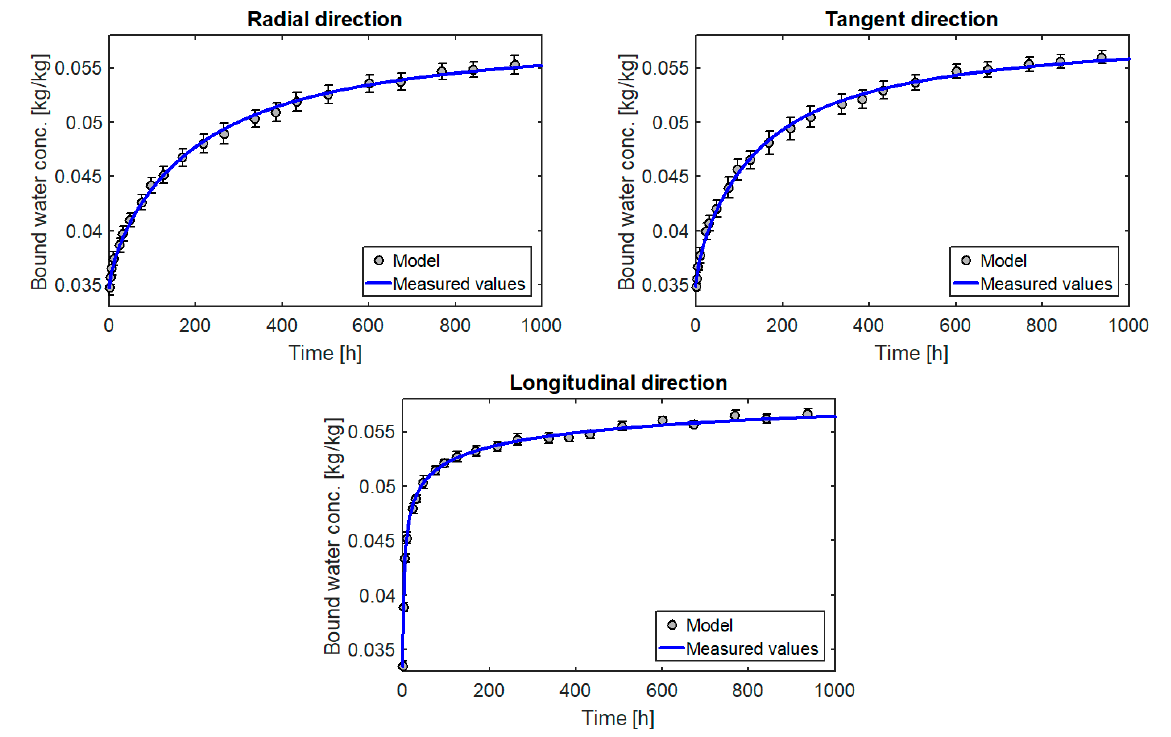
Figure 9. Changes in the moisture content of the larch samples versus time.